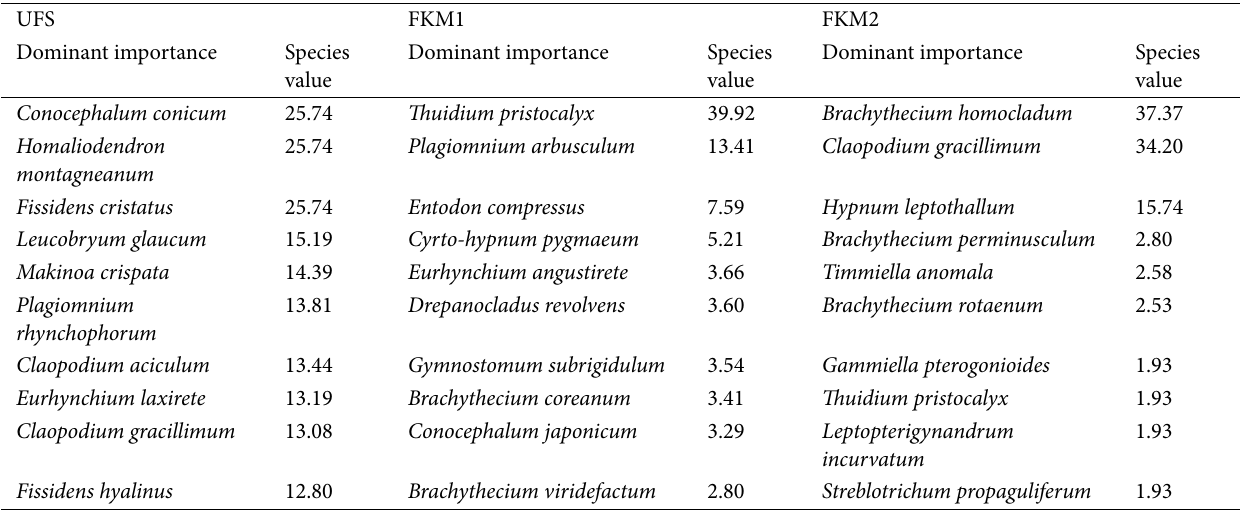
Table 2 Dominant bryophyte species ranked by importance values in the forest within the sinkhole (UFS) and in the forests on the plateau surface (FKM1 and FKM2).